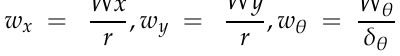
Table 2. Description of the native algorithm of branch and bound scan matcher.